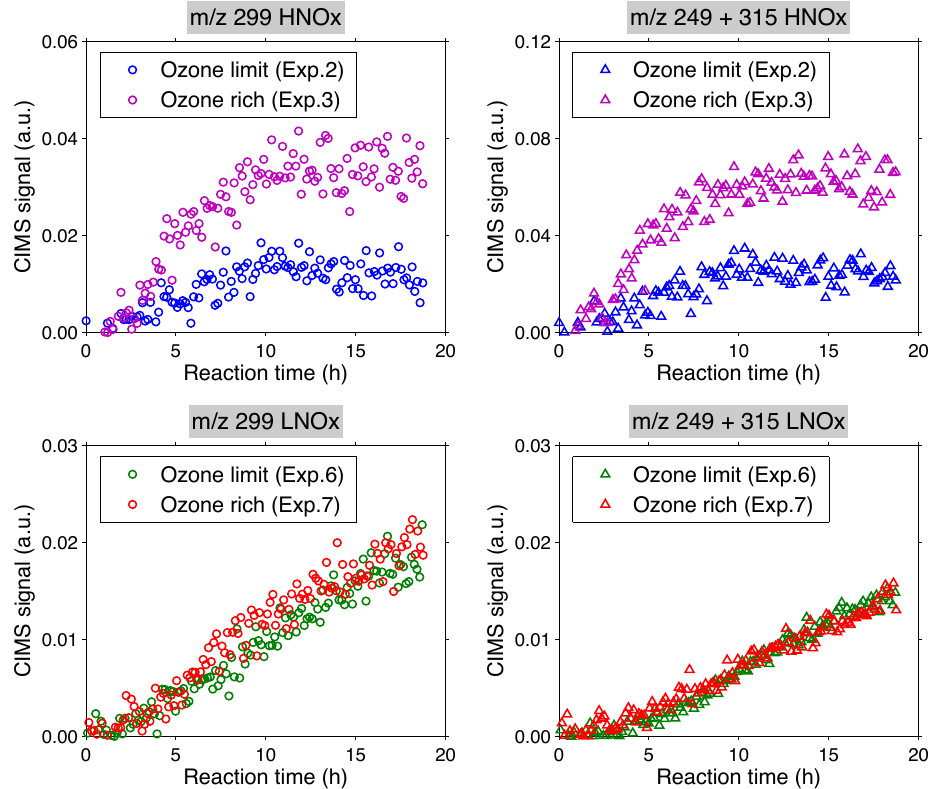
Fig. 6. Time-dependent evolution of CIMS measured signals at m/z 299, and m/z 249 and 315, as a function of O 3 levels under high- and low-NO x conditions over the course of 20h photooxidation.